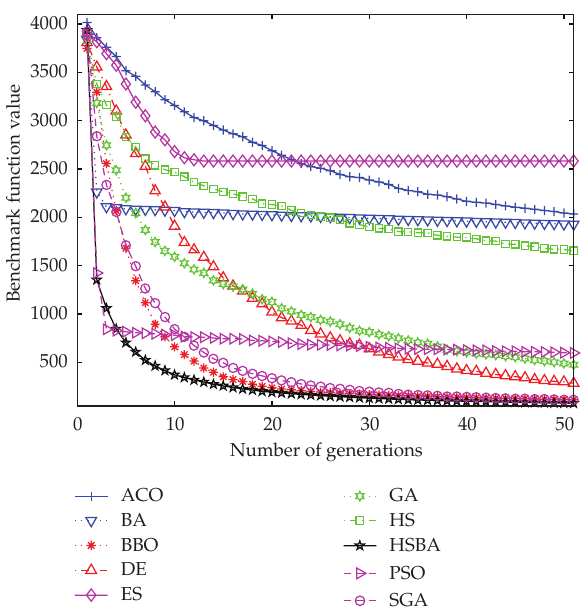
Figure 8: Comparison of the performance of the different methods for the F08 Rosenbrock function.